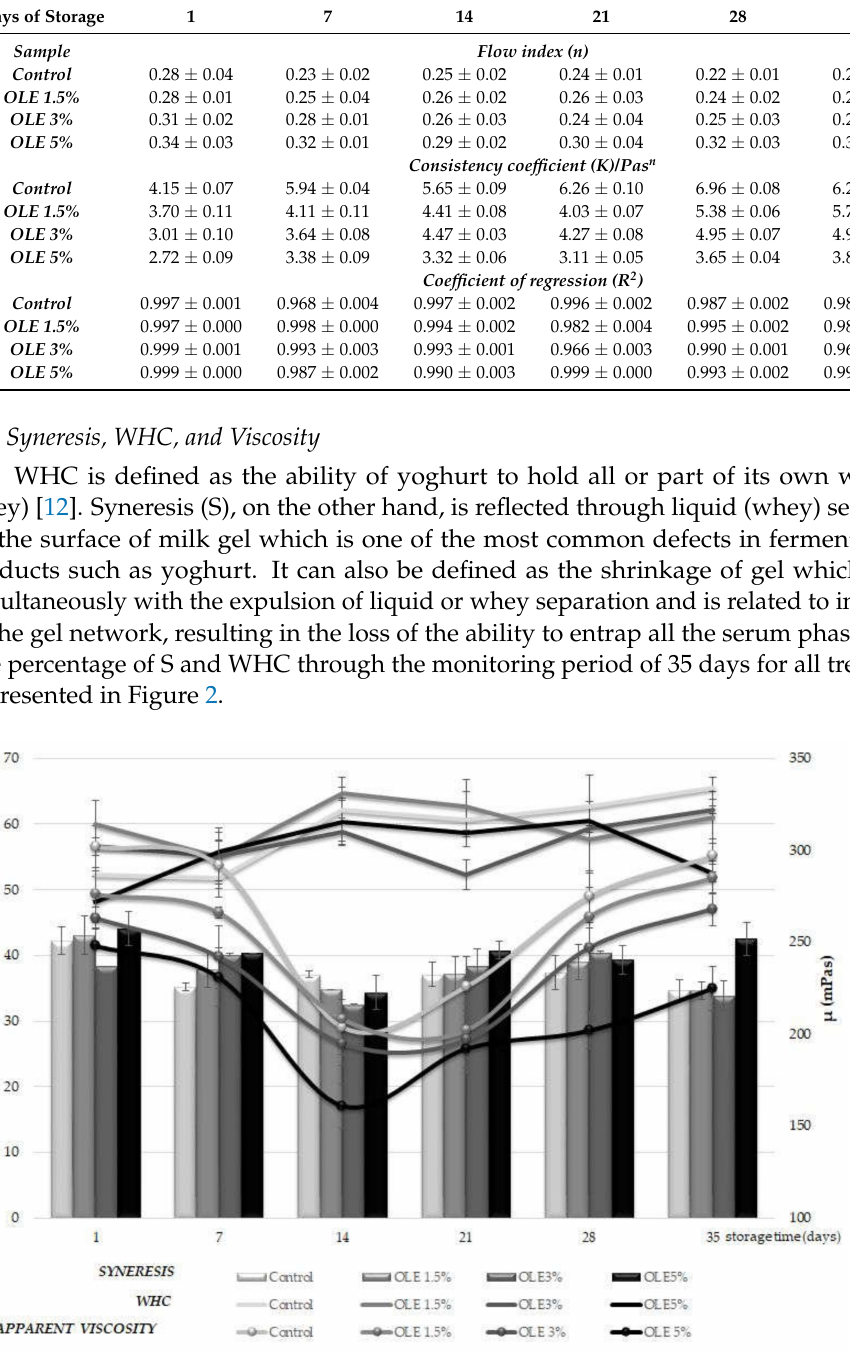
Figure 2. Average values of syneresis (S, %) and water holding capacity (WHC, %) in relation to average apparent viscosity ( µ , m Pa s) at shear rate 100 s − 1 of yoghurt samples without (control) and with olive leaf extract addition (OLE 1.5%, OLE 3%, and OLE 5) during 35 days of cold storage. S and WHC are placed onto primary y -axis, while apparent viscosity is on the secondary y -axis. The obtained values for syneresis were higher for OLE-enriched samples than